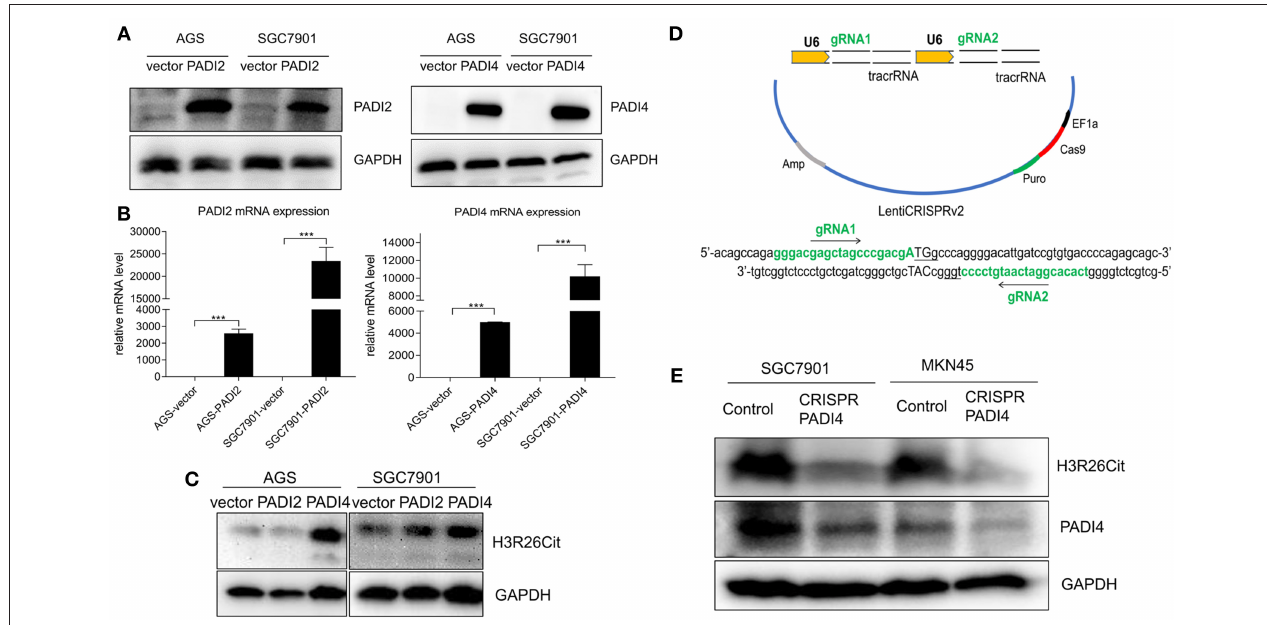
FIGURE 3 | The influence of PADI2 and PADI4 overexpression or knockdown on H3R26Cit. (A) Detection of protein level changes after overexpression of PADI2 and PADI4. (B) Detection of mRNA level changes after overexpression of PADI2 and PADI4 (*** indicates P < 0.001). (C) The protein level of H3R26Cit is significantly increased after enforcing PADI4 expression, compared to enforcing PADI2 expression. (D) Schematic diagram of the construction of CRISPR/Cas9 all-in-one plasmid system with a double target on the PADI4 gene. (E) The protein level of H3R26Cit is significantly decreased after knockdown of PADI4 in both SGC7901 and MKN45 gastric cancer cell